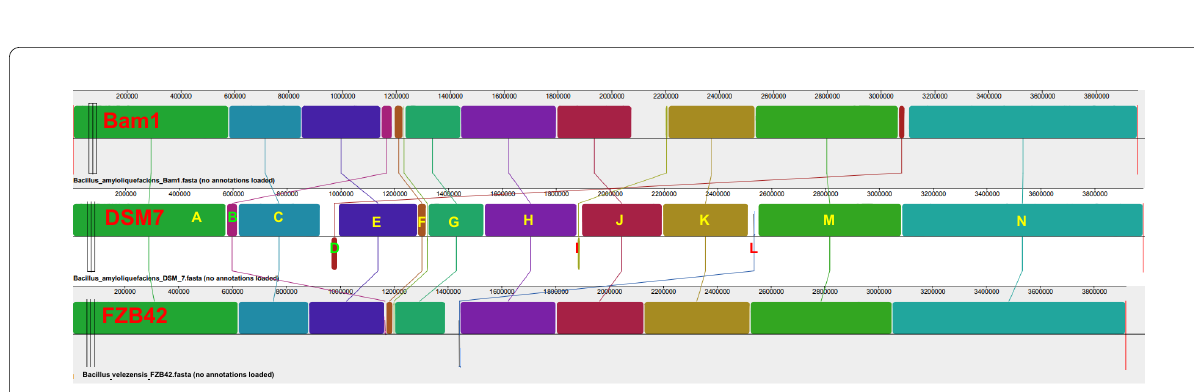
Fig. 6 Co-linearity analysis for the B. amyloliquefaciens strains of Bam1 and DSM7, as well as B. velezensis